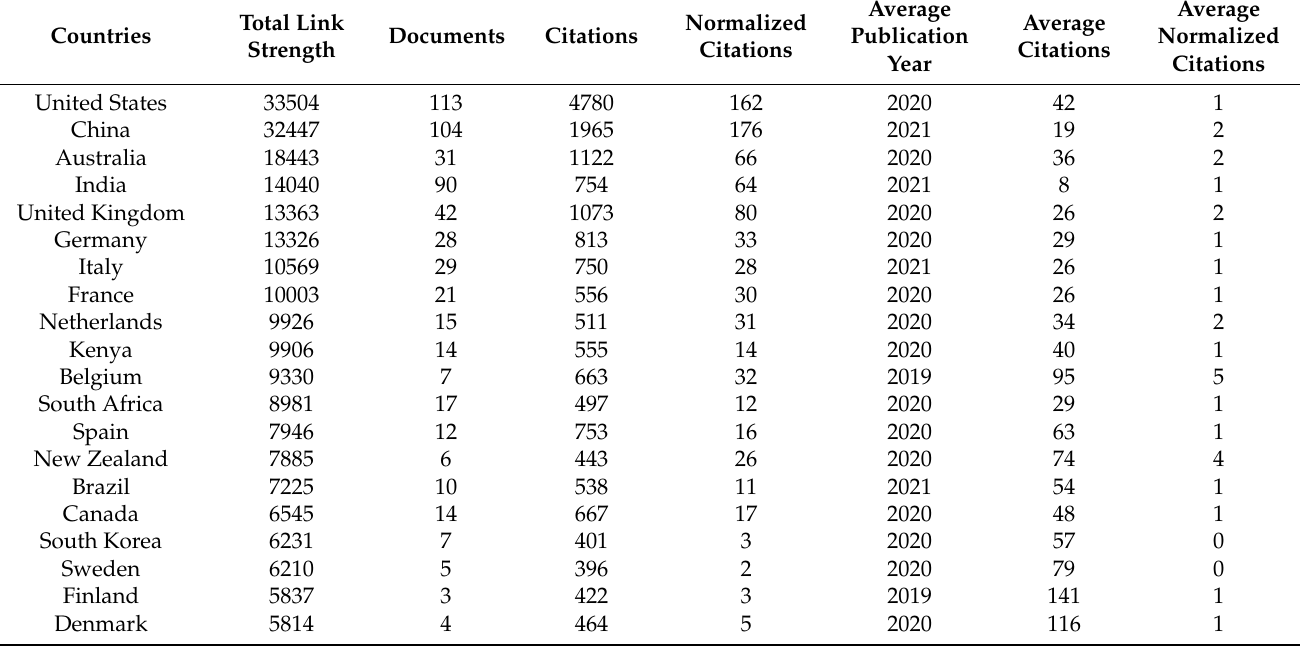
Figure 3. Network visualization map for bibliographic data (bibliographic coupling links and countries as items), considering full counting and 1 as the minimum number of occurrences of a country. Table 3. Top 20 countries with the highest total link strength for bibliographic data, considering full counting and 1 as the minimum number of occurrences of a country.